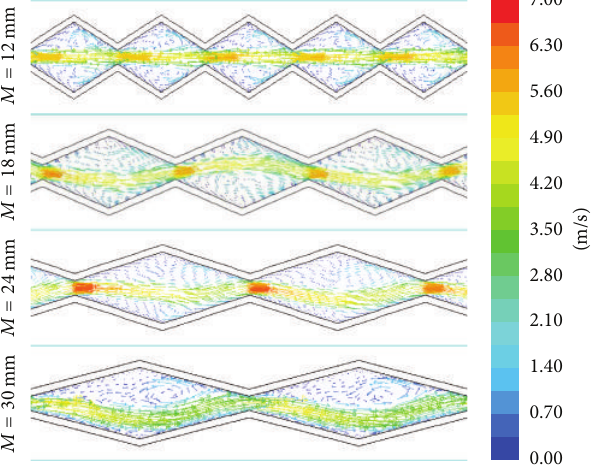
Figure 9: Velocity vector for different tooth lengths.